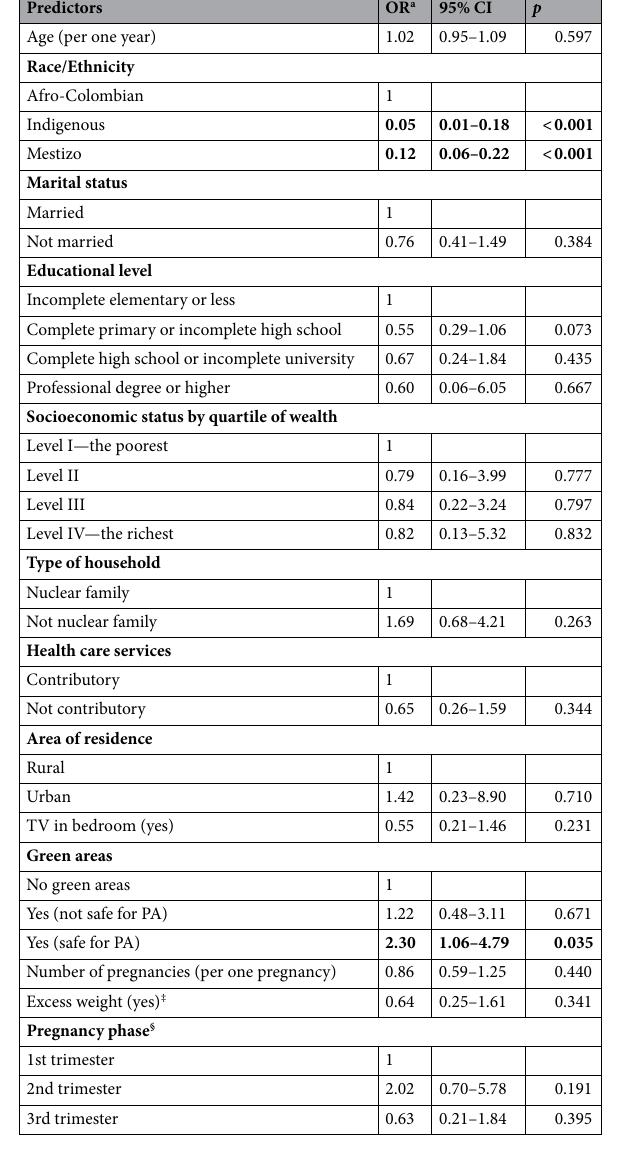
Table 2. Multilevel mixed effects logistic regression analysis with potential socioecological factors as independent variables and meeting the physical activity recommendations as a dependent variable, among Colombian pregnant women. Data expressed as a odds ratio and 95% confident intervals. Bold indicates correlates with p -value < 0.05. OR odds ratio, PA physical activity. † Non-meeting the physical activity recommendations selected as a reference group. ‡ Prevalence of excess of weight according to the cut-off points proposed by Atalah et al. 27 for pregnant women. § According to the week of the last menstruation